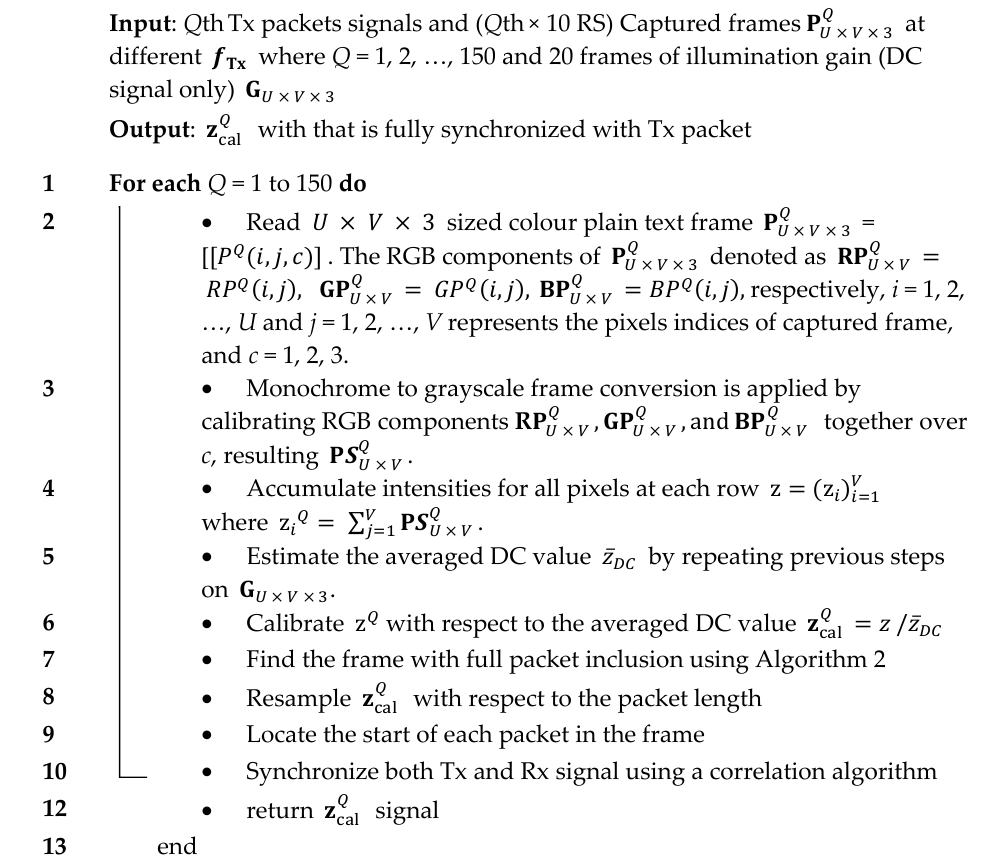
Algorithm 1 Signal Extraction Algorithm